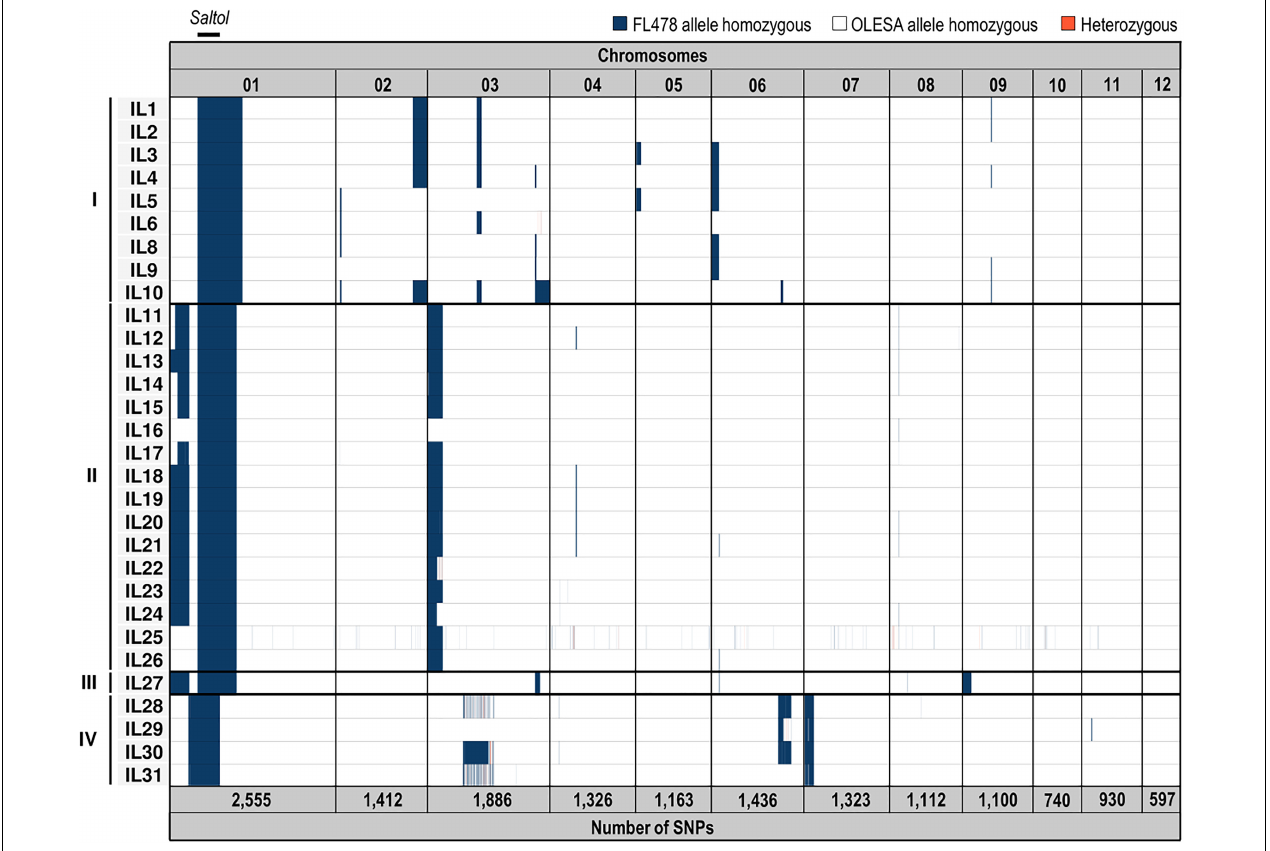
FIGURE 1 | Genotyping-by-sequencing analysis of introgression lines. Scheme representing SNPs variation and its distribution among the 12 chromosomes in BC 3 F 4 introgression lines. SNPs are indicated in columns according to their chromosomal location. Introgression lines (IL1 to IL31) are clustered in four groups (I to IV) depending on the BC 3 F 1 parent from which they derive. The Saltol QTL location (and length) is indicated in the upper part. The total number of SNPs found in each chromosome is indicated in the lower part. Donor (FL478) and recurrent (OLESA) homozygous alleles in the 12 chromosomes are depicted in blue and white, respectively, and heterozygous in red. A detailed description of SNPs is provided in Supplementary Table 3 .